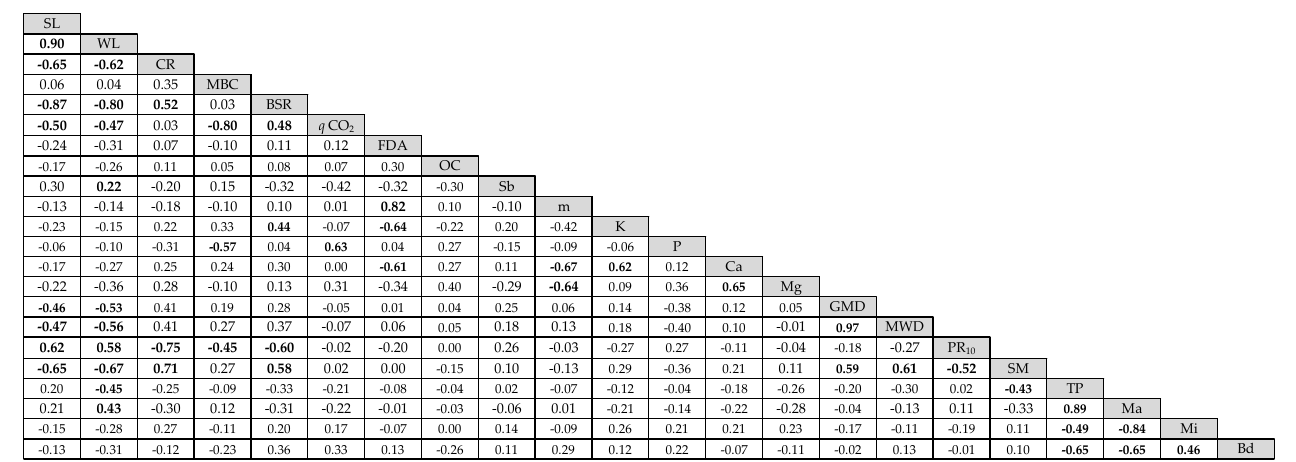
Figure 6. Pearson correlation matrix for variables sampled in crop interrows. SL = soil losses, WL = water losses, CR = cover rate, MBC = microbial biomass carbon, BSR = basal soil respiration, qCO2 = metabolic quotient, FDA = fluorescein diacetate hydrolysis, Sb = sum of bases, m = aluminum saturation of soil, Mg = magnesium, MWD = mean weight diameter, PR 10 = soil resistance to root penetration at 10 cm depth, SM = soil moisture in situ, and Bd = bulk density. Values in bold print: significant at 5%.